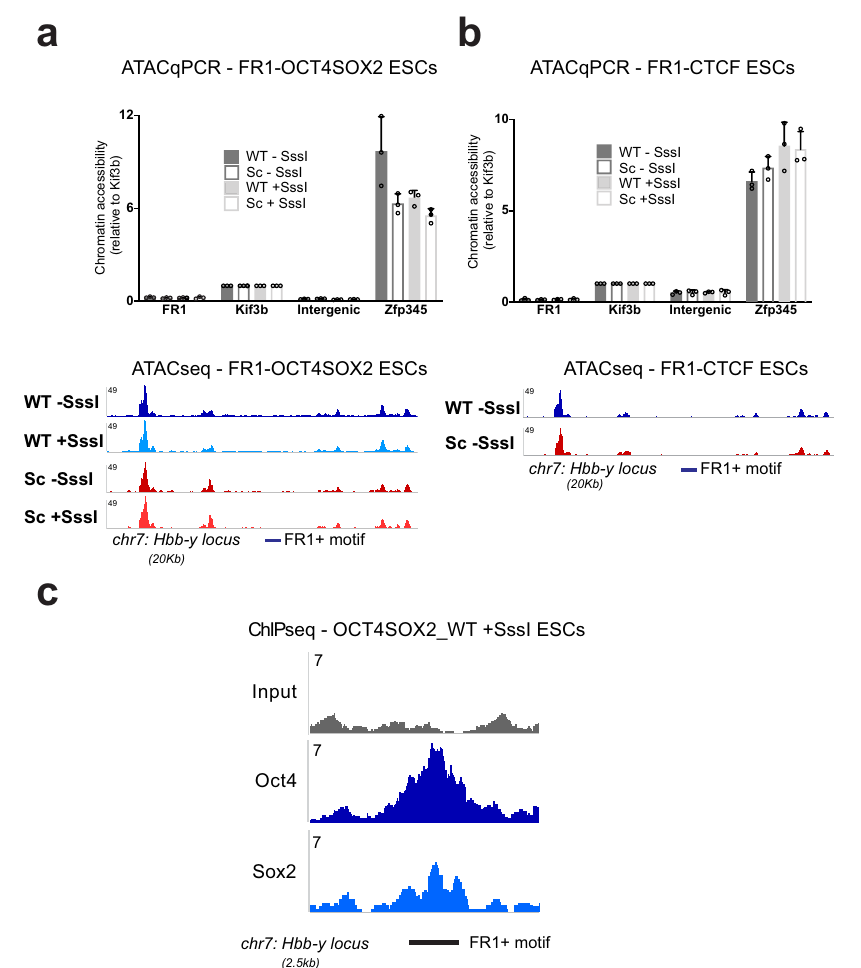
Fig. 5 SPF activity is not suf fi cient, in isolation, to generate chromatin accessibility. a , b Upper panels. Results of ATAC-qPCR experiments in FR1_OCT4SOX2 ESCs ( a ) and FR1_CTCF ESCs ( b ) containing WT and Sc motifs in − SssI and + SssI conditions. We measured very low levels of chromatin accessibility at the FR1 locus in all four conditions when compared to known accessible ( Zfp345 large ATAC-peak; Kif3b medium ATAC-peak) and inaccessible ( Intergenic small ATAC peak) regions of the chromatin in mESCs 97 . Results are shown as mean + SD of n = 3 biologically independent replicates. Source data are provided as a Source data fi le. Lower panels. Representative genome browser tracks of the chromatin accessibility landscape around the FR1 locus. ATAC-Seq experiments were performed in FR1-OCT4SOX2 ESCs containing WT/±SssI and Sc/±SssI motifs ( a ) and in FR1-CTCF ESCs containing WT/ − SssI and Sc/ − SssI motifs ( b ). The ATAC-Seq signal is low over the FR1 locus compared to neighbouring accessibility peaks, highlighting the low levels of chromatin accessibility, which remain unchanged despite SPF binding in the WT conditions. c OCT4 and SOX2 ChIP-Seq in FR1 OCT4SOX2 ESCs reveals binding of both TFs at the FR1 locus. Displayed are representative genome browser tracks of the ChIP-Seq data across the FR1